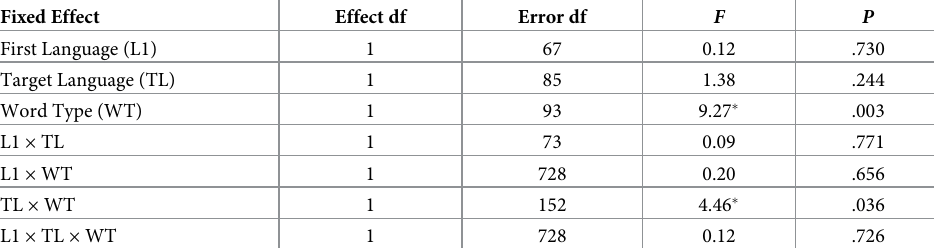
Table 2. Fixed effects results from LMMs considering bilingual participants